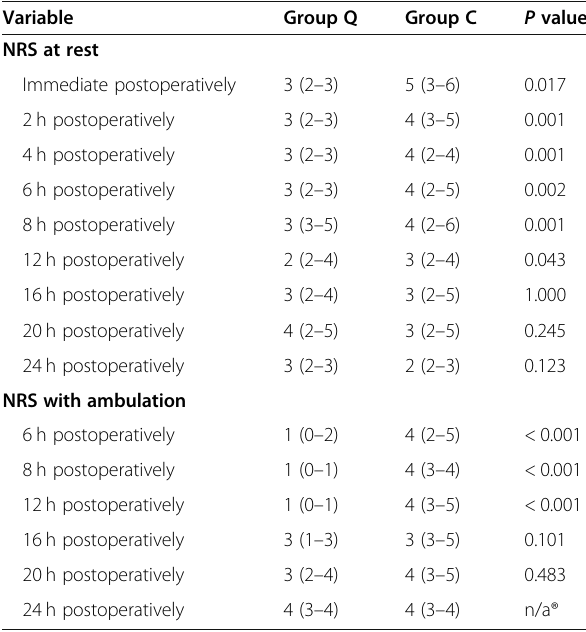
Table 4 Comparison between the 2 groups regarding the medians of the NRS score